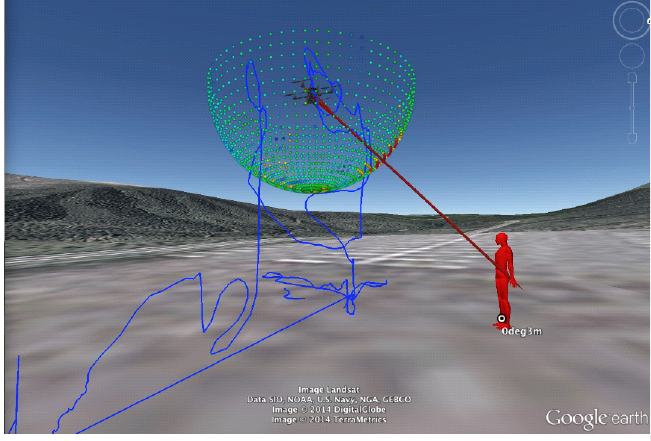
Figure 5. MUSIC (multiple signal classification) spectrum. ( a ) azimuth direction; ( b ) elevation direction.